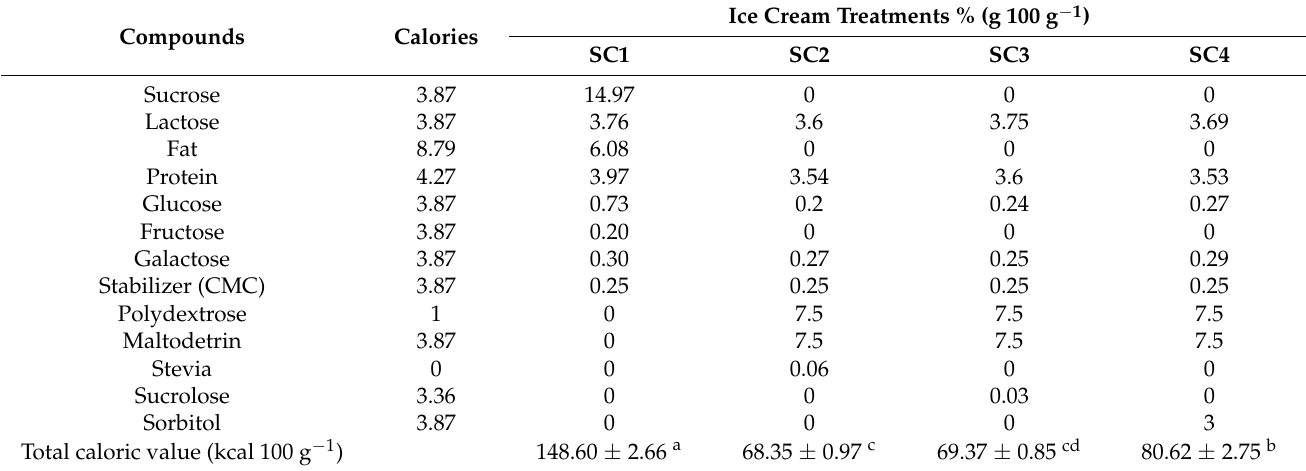
Table 6. Total caloric values of the ice cream treatments (means ±